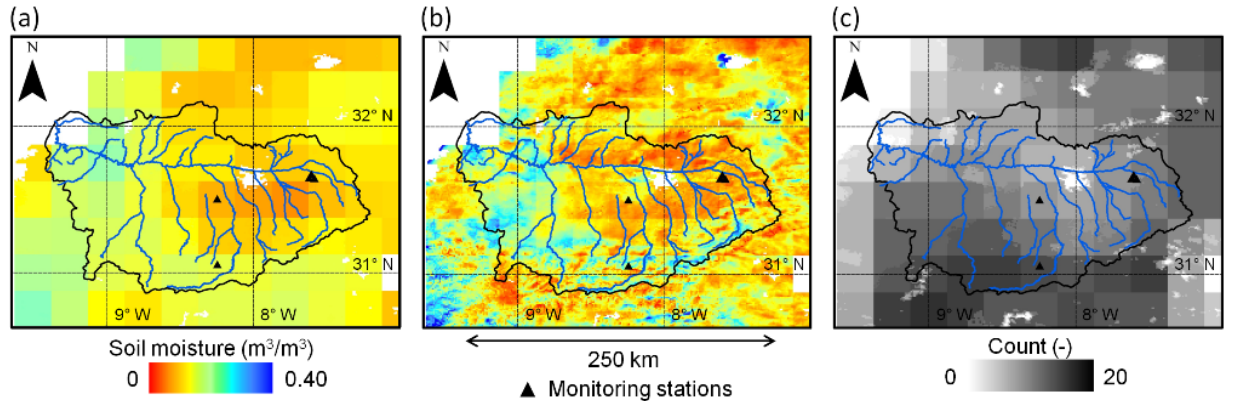
Figure 3. Images over the Tensift basin of: ( a ) Soil Moisture Ocean Salinity (SMOS) soil moisture (SM ); ( b ) 1-km resolution disaggregation based on physical and theoretical LR scale change (DISPATCH) soil moisture (SM ); and ( c ) DISPATCH input data count on 6 HR October